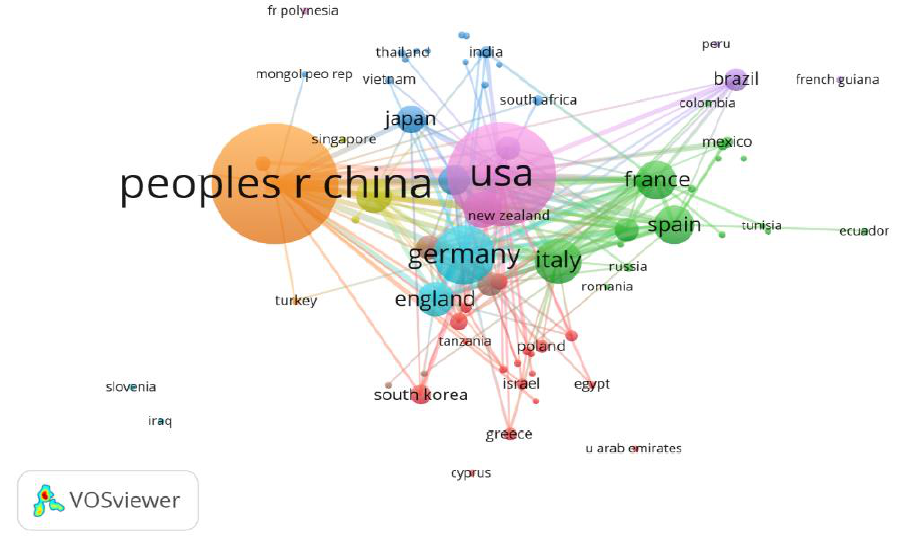
Figure 6. Network Impact Diagram. Number of publications and co-authorship cooperation between countries.